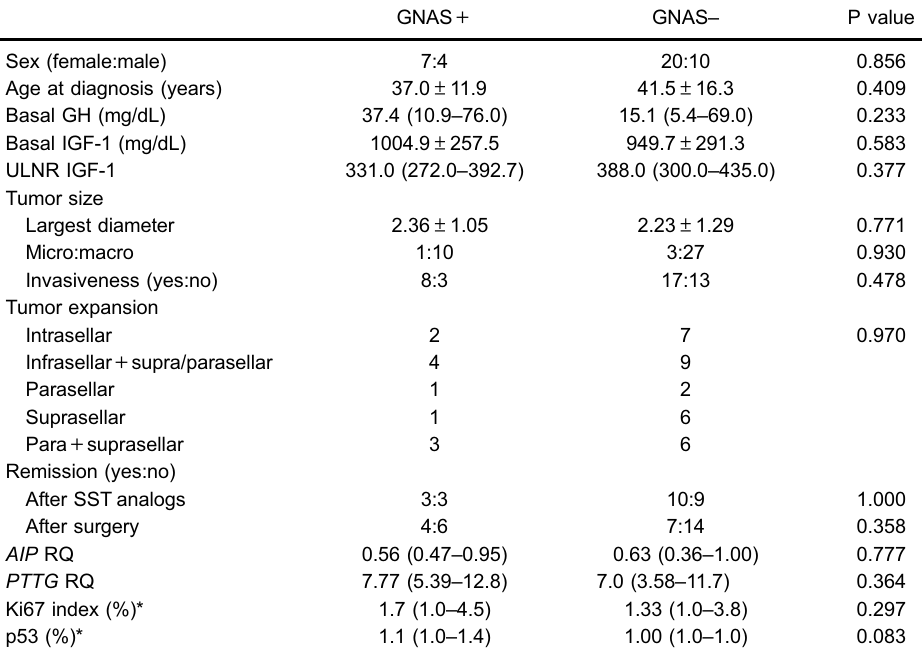
Table 2. Characteristics of mutated versus non-mutated GNAS patients with